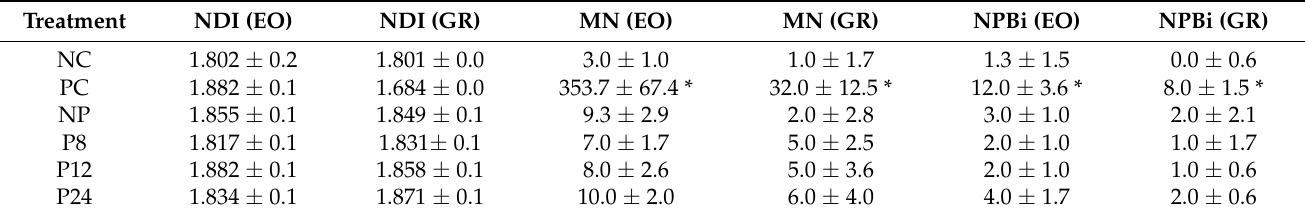
Table 2. CBMN assay in CHO-K1. Mean and standard error of nuclear division index (NDI), frequency of micronuclei (MN) and frequency of nucleoplasmic bridges (NB) of collagen membranes sterilized by ethylene oxide (EO) and gamma ray (GR). * = p < 0.05 (Tukey and